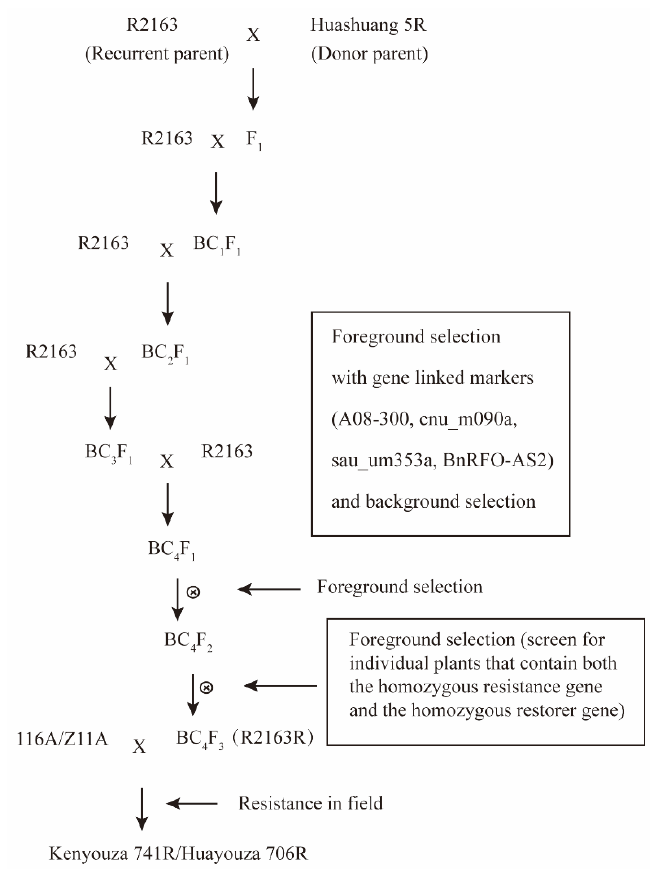
Figure 7. Scheme for the development of PbBa8.1 loci into R2163.